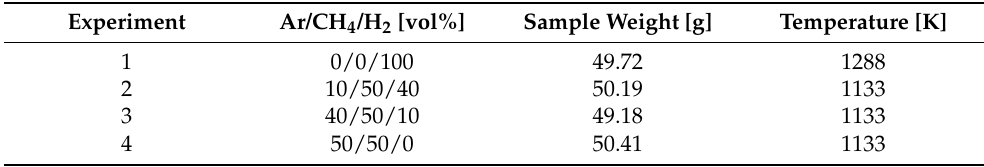
Table 1. The reduction conditions in the stationary bed reactor.